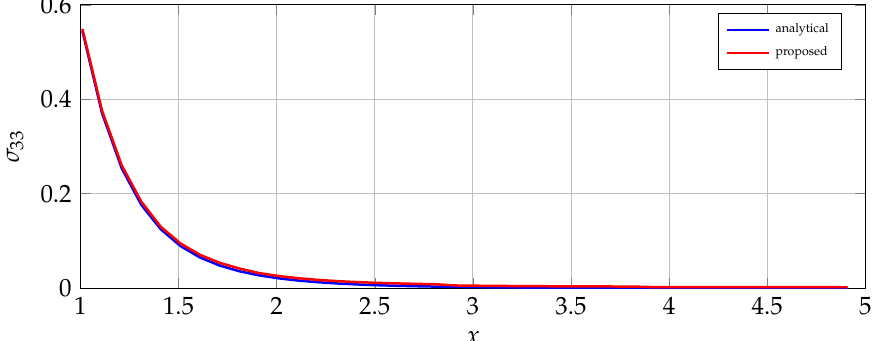
Figure 7. Stress distribution around the hole for distance x > 1 from the centre of the hole (size does not corresponds to